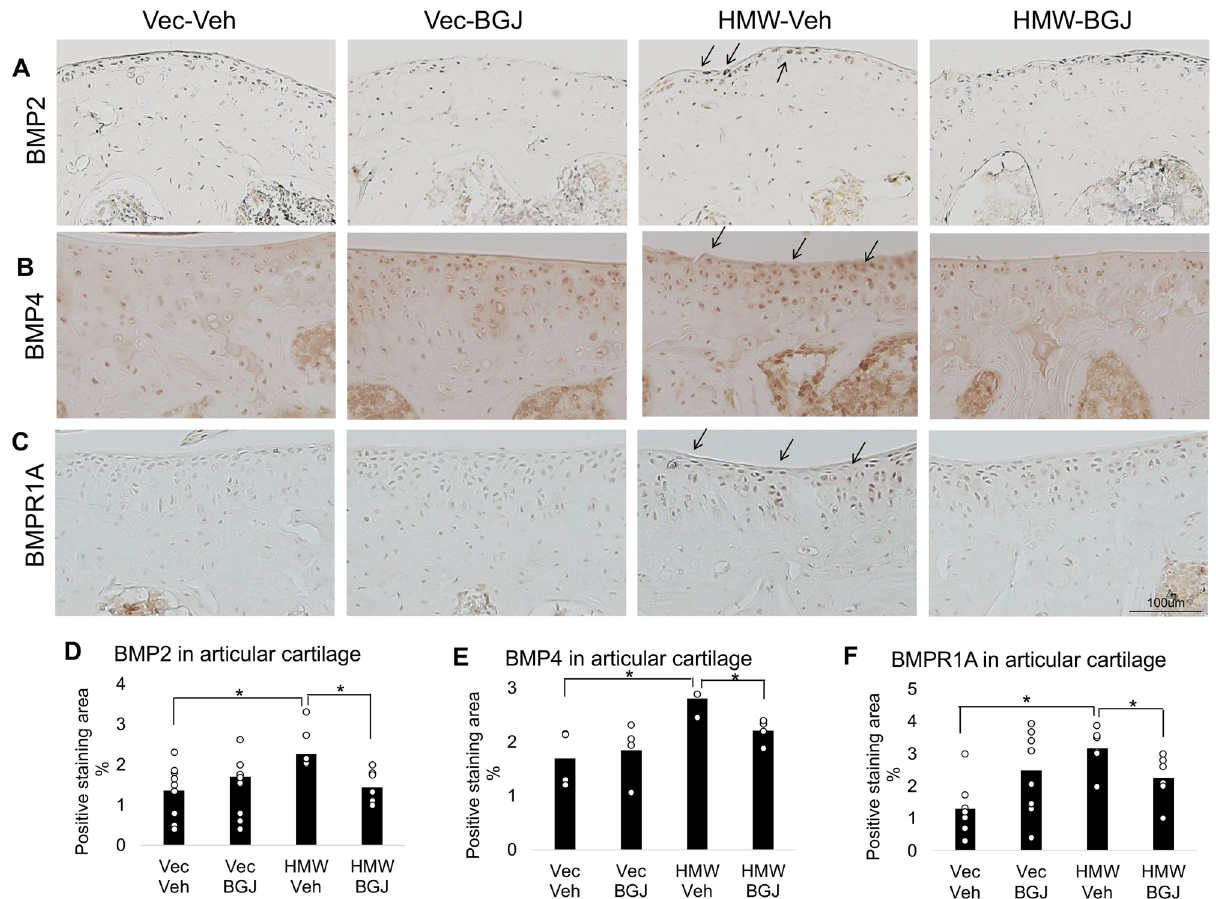
Figure 8. Expression of BMP2, BMP4, and BMP receptor1 in knee articular cartilage of 9.5-month-old Vector- Control and HMWTgFGF2 mice treated with BGJ398. Eight-month-old Vector-Control and HMWTgFGF2 female mice were sq injected with vehicle or BGJ398 5 days/week for 6 weeks. At the end of the experiment (9.5 months old) knee joints were collected for IHC staining. Representative immunohistochemical staining images for ( A ) BMP2, ( B ) BMP4, and ( C ) BMPR1A. Quantitative analysis of percent-positive staining area for ( D ) BMP2, n = 7–9 mice/group, ( E ) BMP4, n = 4 mice/group, and ( F ) BMPR1A, n = 7–9 mice/group, in articular cartilage. Data are shown as mean and individual points. n = 7–9 mice/group. *p < 0.05 by two-way